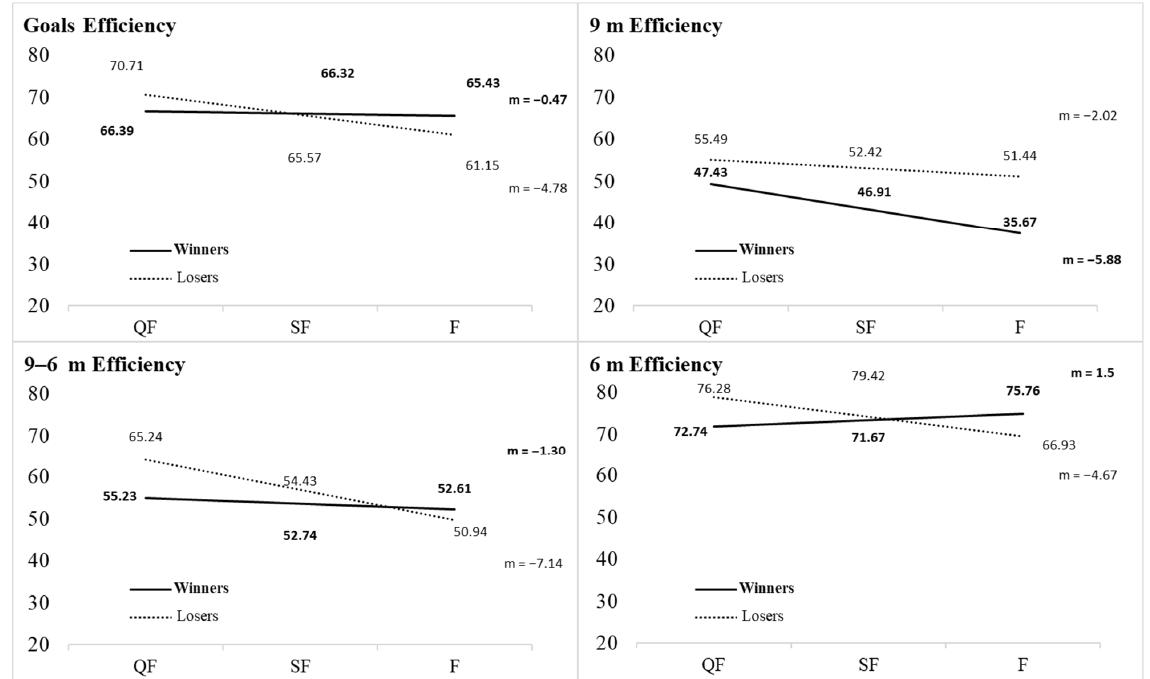
Figure A3. Linear tendency lines of game action. Note: QF= Quarterfinals; SF= Semifinals; F= Finals.